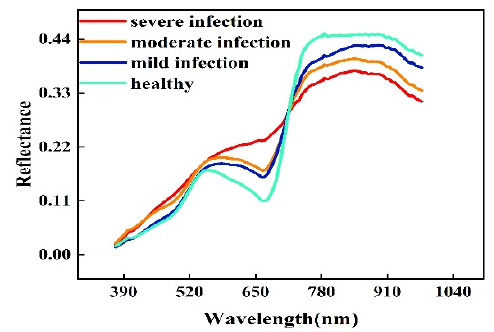
Figure 4. Spectral reflectance curves of wheat ears with different disease severities.